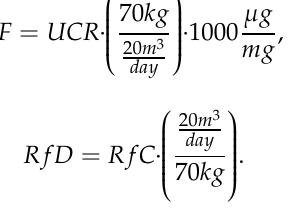
Table 3. Toxicological